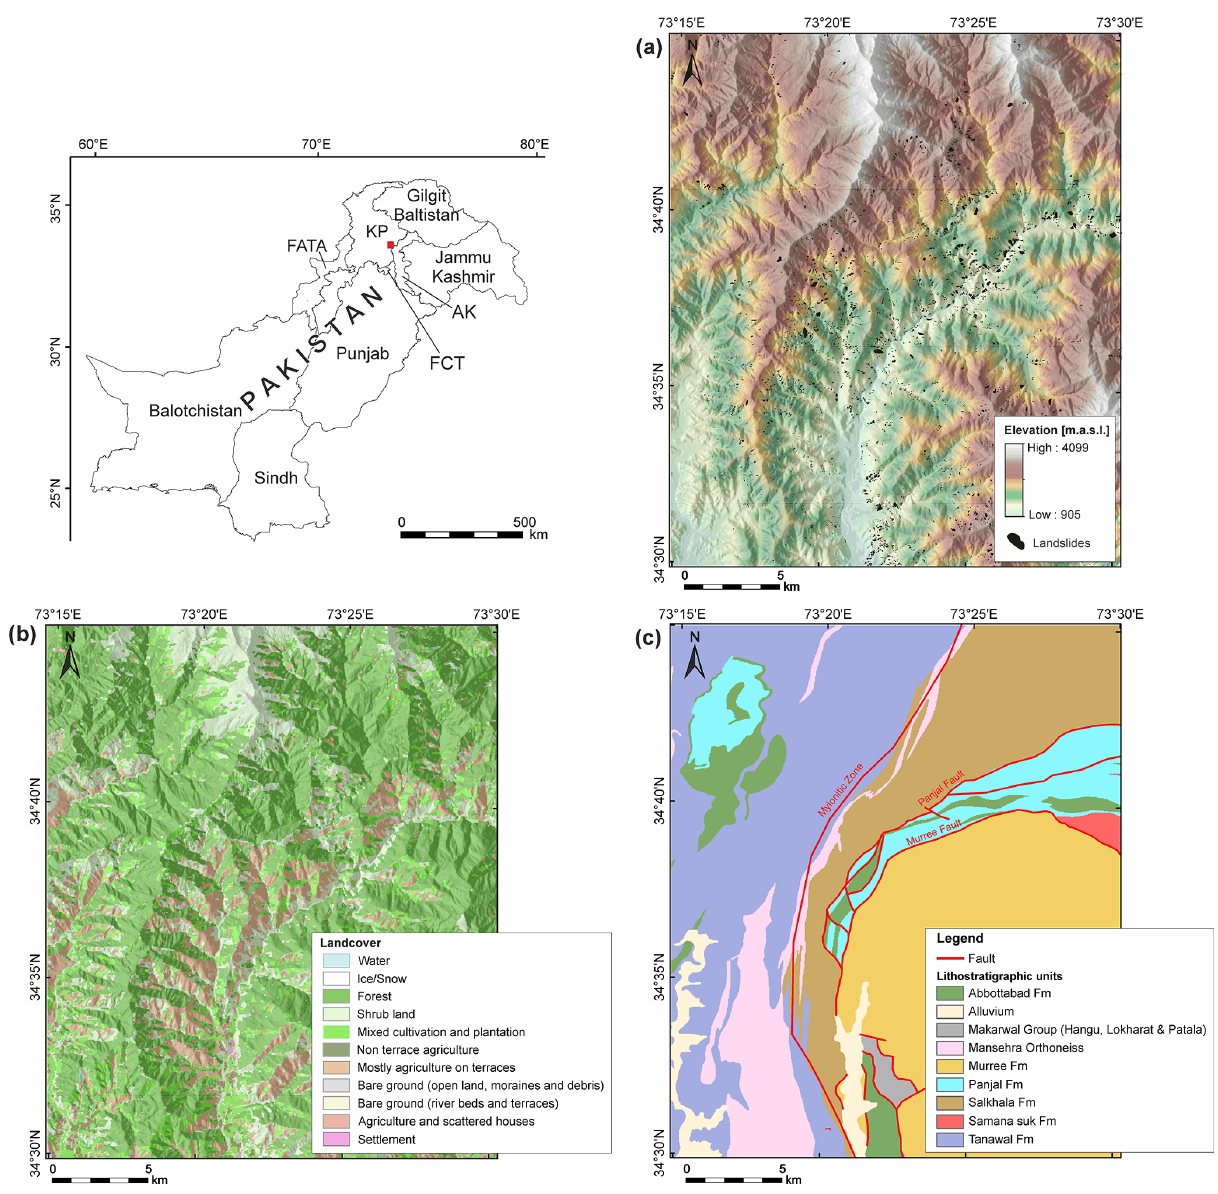
Figure 5. Example dataset. (a) AW3D30 with landslide inventory; (b) land cover; (c) geology with prominent (confirmed)